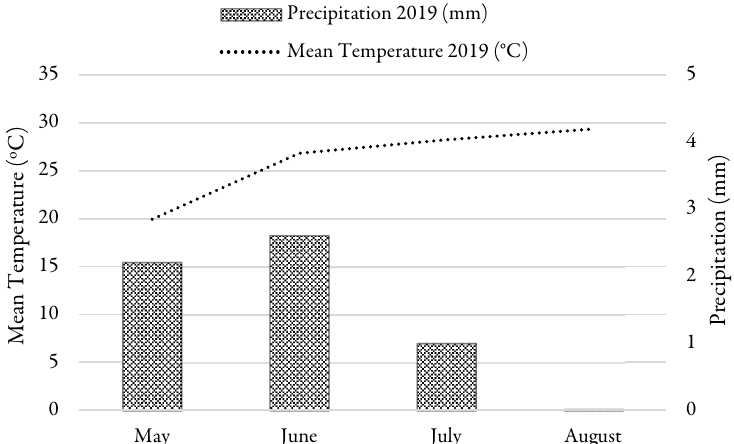
Figure 1. Meteorological data (mean temperature and precipitation during the growing period (May- August